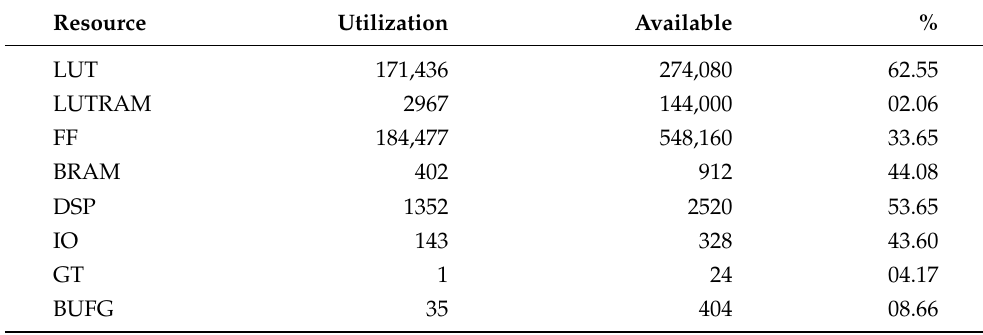
Table 3. CHP2 logical resource utilization on ZynqMP